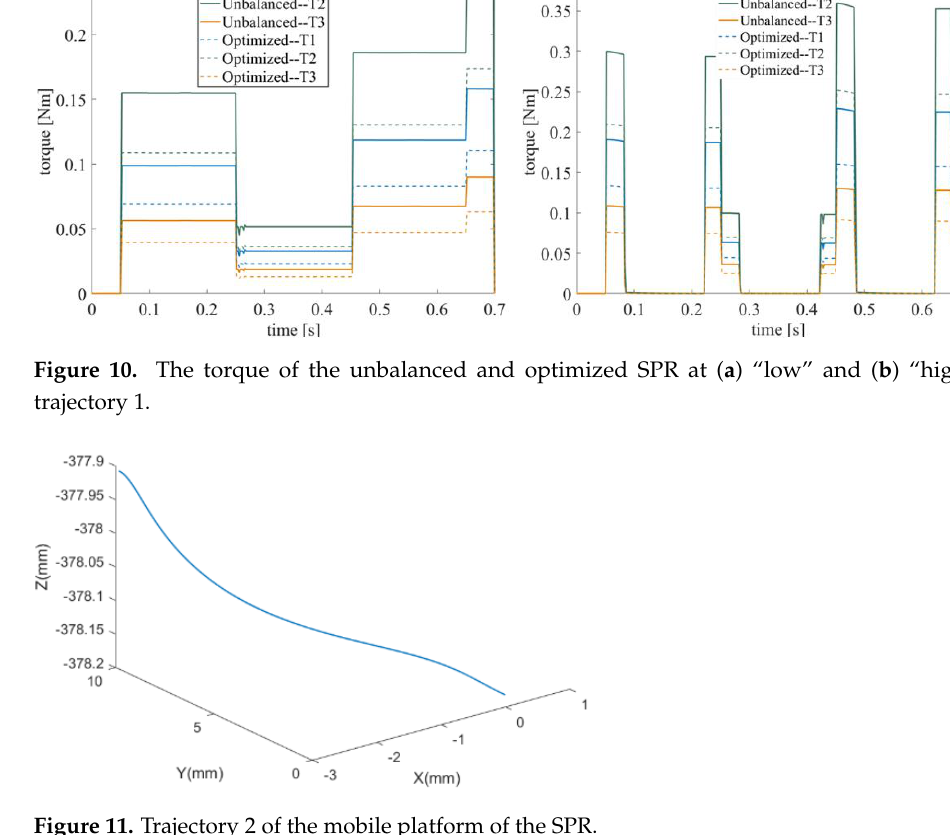
Figure 11. Trajectory 2 of the mobile platform of the SPR.